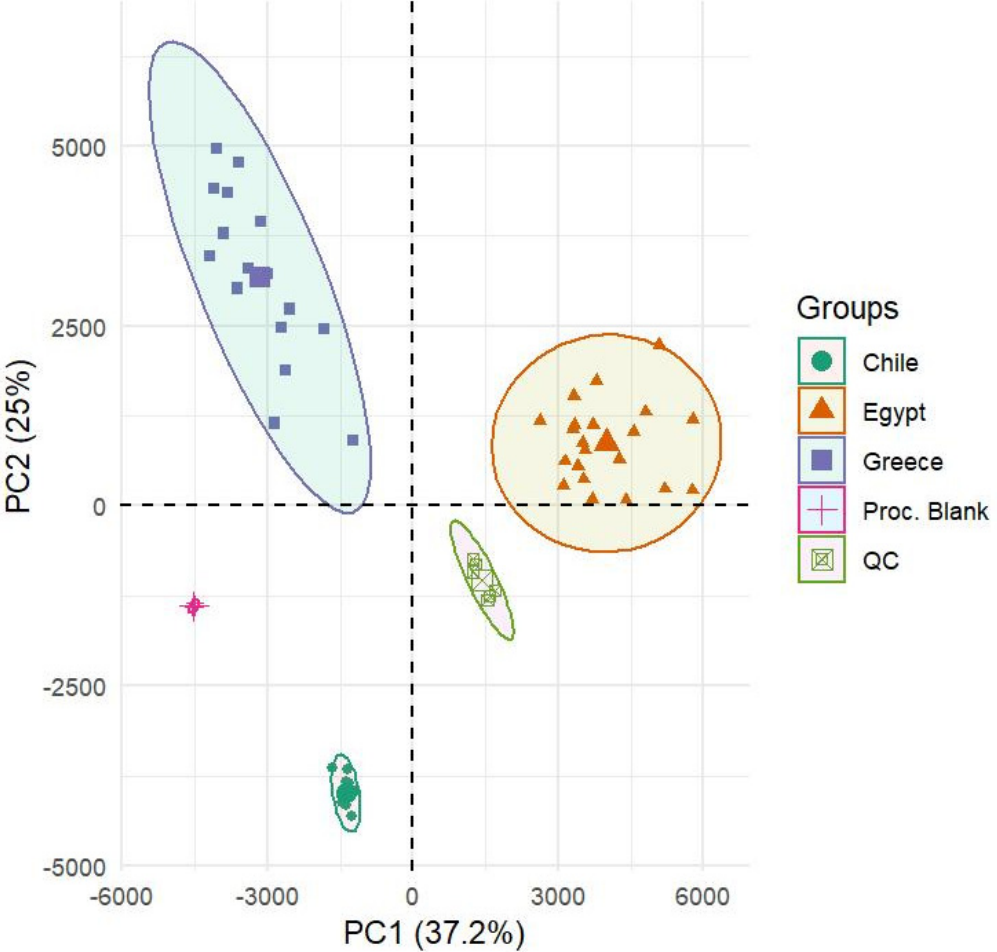
Figure 1. Principal Component Analysis (PCA) score plot of Quality Control (QC) samples, analytical procedural blank, and Kalamon table olives from different geographical origin.